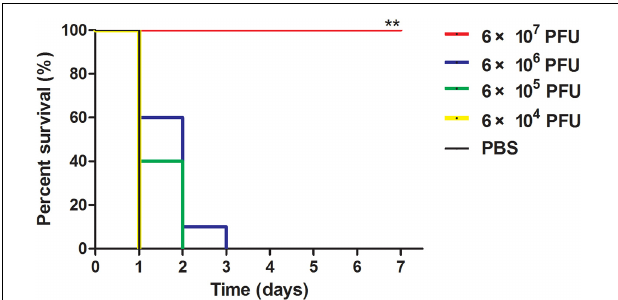
FIGURE 5 | Survival rates of infected mice. Mice were intraperitoneally challenged with T. pyogenes BS (6 × 10 8 CFU/mouse), and infected mice were intraperitoneally treated with different doses of JF1 30 min postinfection. The control group was treated with the same amount of sterile PBS. Compared to the other groups, 6 × 10 7 PFU/mouse JF1 significantly improved the survival rate of infected mice. Each group contains 10 mice. ** P <